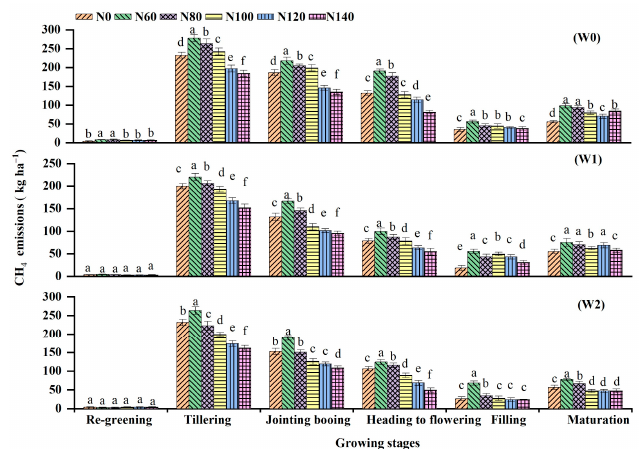
Figure 5. Seasonal CH 4 emissions affected by irrigation regimes with different N application rates during the rice-growing period. W0, W1, and W2 represents continuous flooding, intermittent irrigation, and control irrigation (W2), respectively. Urea application at rates of 0 (N0), 60 (N60), 80 (N80), 100 (N100), 120 (N120), and 140 (N140) kg N ha − 1 . Values followed by the different letter are significant different at p < 0.05.